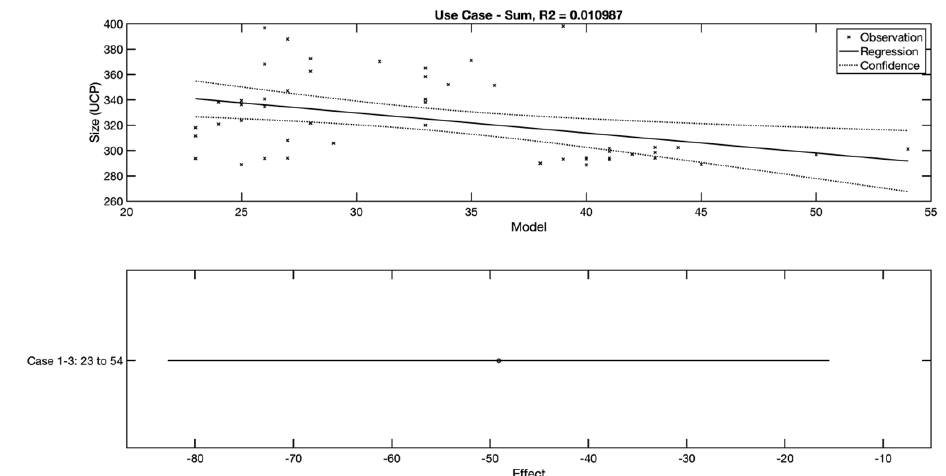
Figure 11. Graph illustrating the benefit of individual use case types.